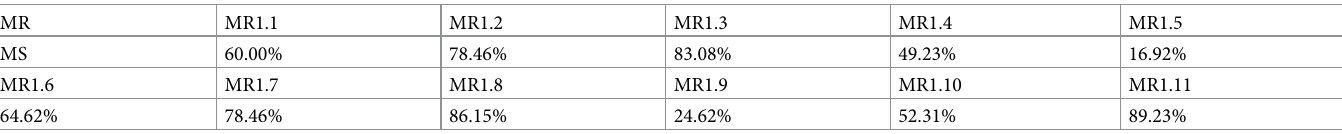
Table 6. Mutation scores of MRs for the ATM withdrawal event for all